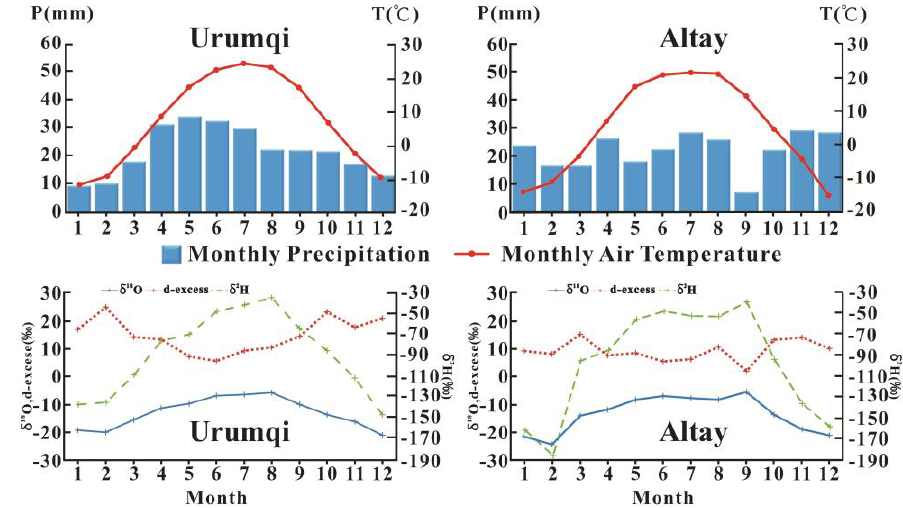
Figure 4. Seasonal variations of precipitation amount and temperature at Urumqi and Altay stations, and seasonal variations of δ 18 O, δ 2 H, and d-excess at Urumqi and Altay stations.